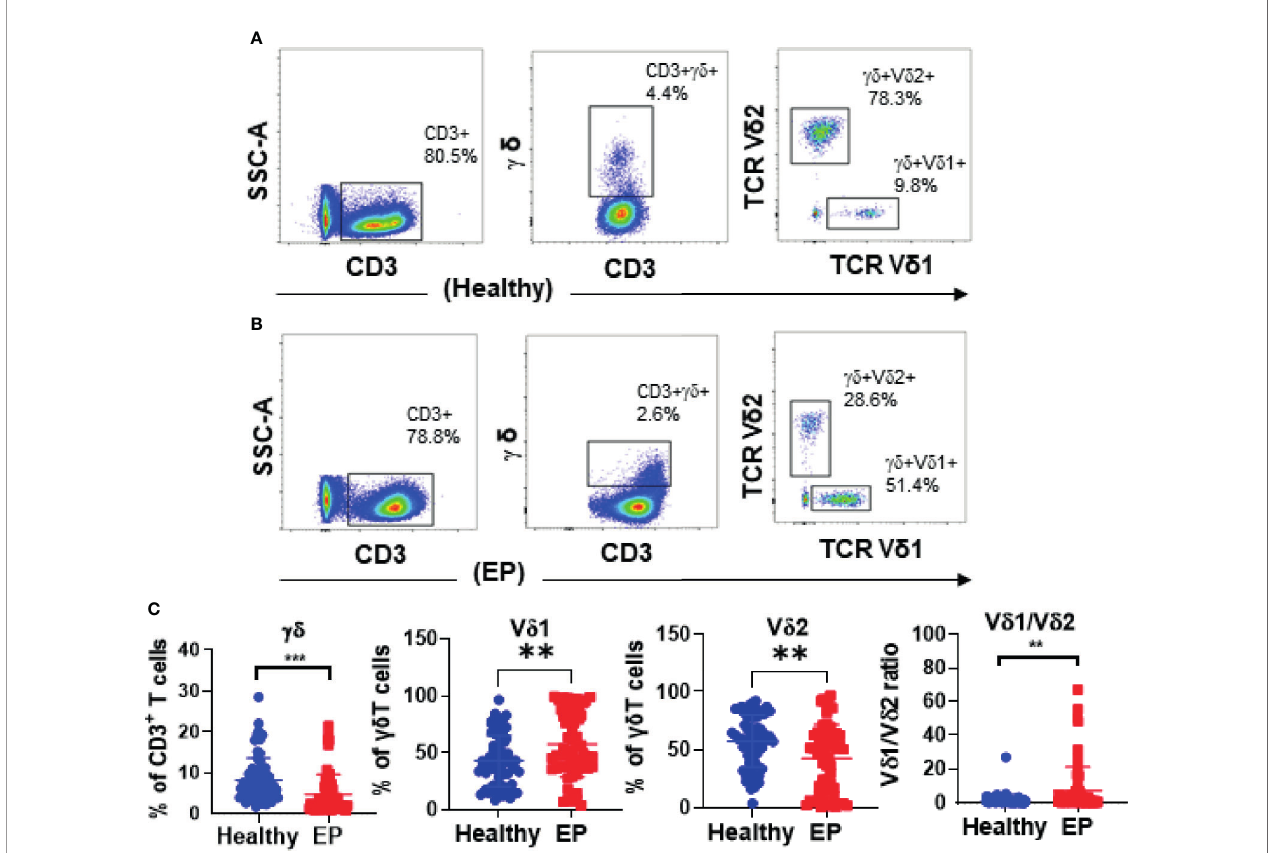
FIGURE 2 | Representative fl ow graphs (A, B) and statistical analysis results (C) . (C) Statistical comparison of gd T cell proportions in CD3+ T cells, V d 1 and V d 2 subsets in gd T cells, and the V d 1 + /V d 2 + ratio between the healthy group and the patient group. **P < 0.01. ***P <